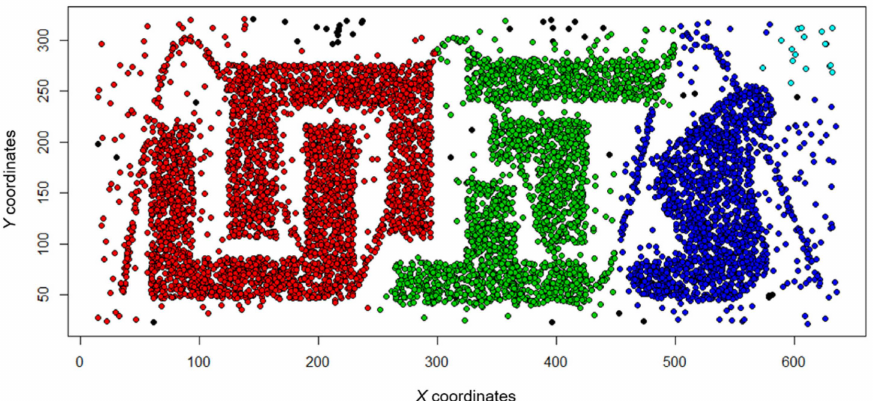
Figure 7. Results of spatiotemporal clustering using 4D + SNN.